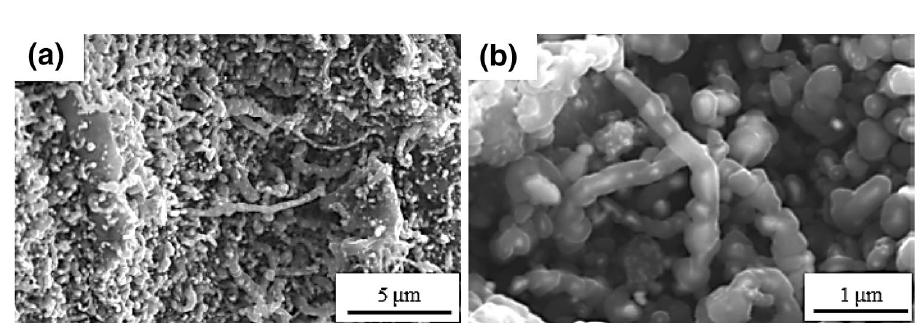
Fig. 9 Morphologies of